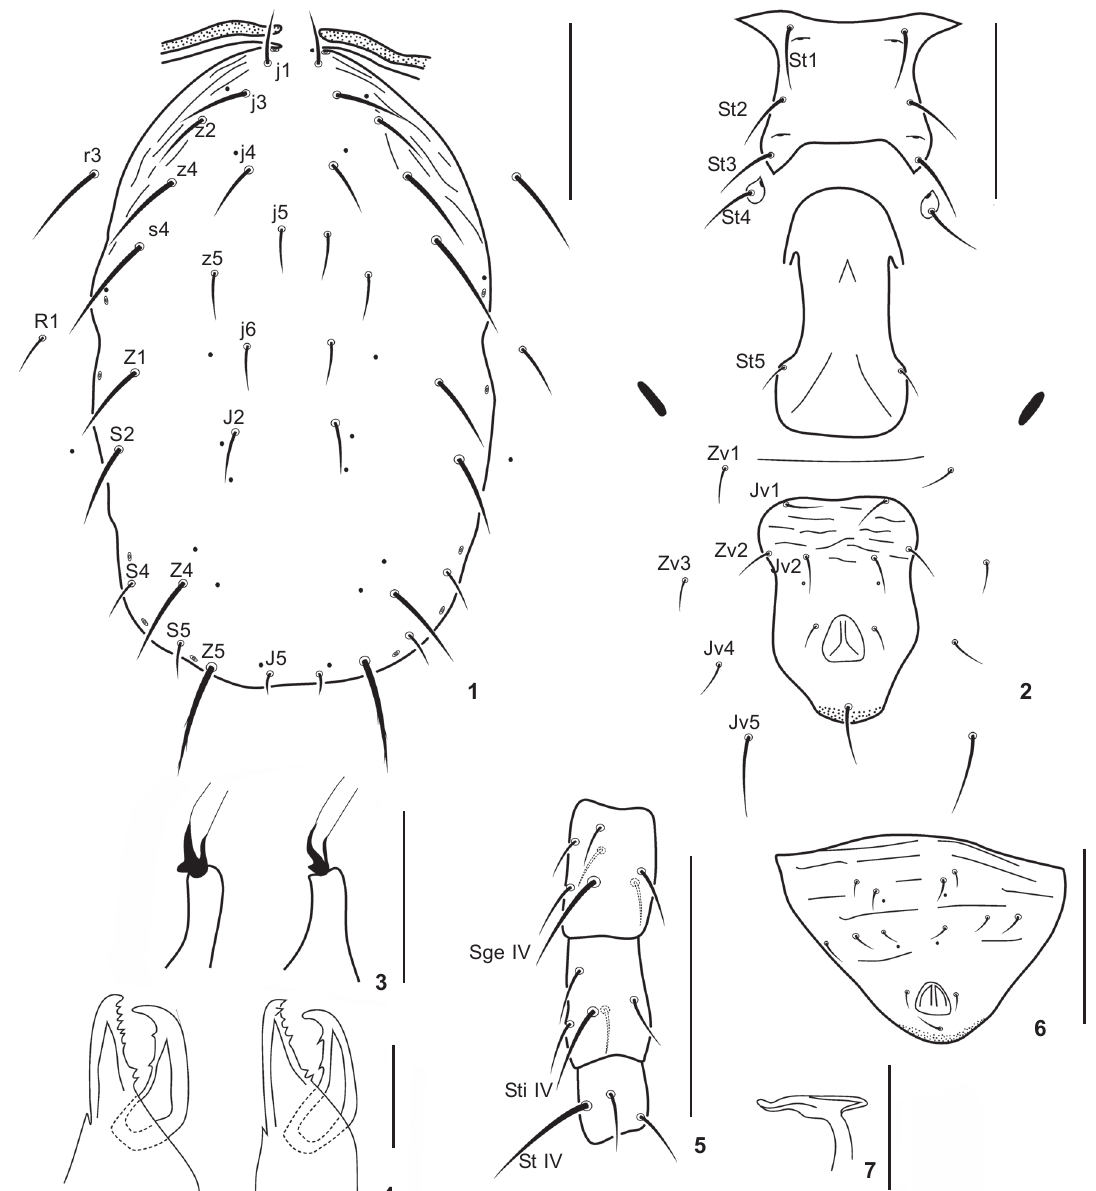
Figures 1-7. Neoseiulus demitei sp. nov. (1-5) Female: (1) dorsal shield; (2) ventral surface; (3) spermatheca; (4) chelicera; (5) leg IV: genu, tibia and basitarsus. (6-7) Male: (6) ventri-anal shield; (7) spermatodactyl. (j-J) Dorso-central setae, (JV) medial ventral setae, (r- R) marginal setae, (Sge, Sti, St) setaceous macrosetae, (s-S) lateral setae, (ST) sternal setae, (ZV) mediolateral ventral setae, (z-Z) mediolateral setae. Scale bars: 1, 2, 5, 6 = 100 µm, 3, 4, 7 = 20